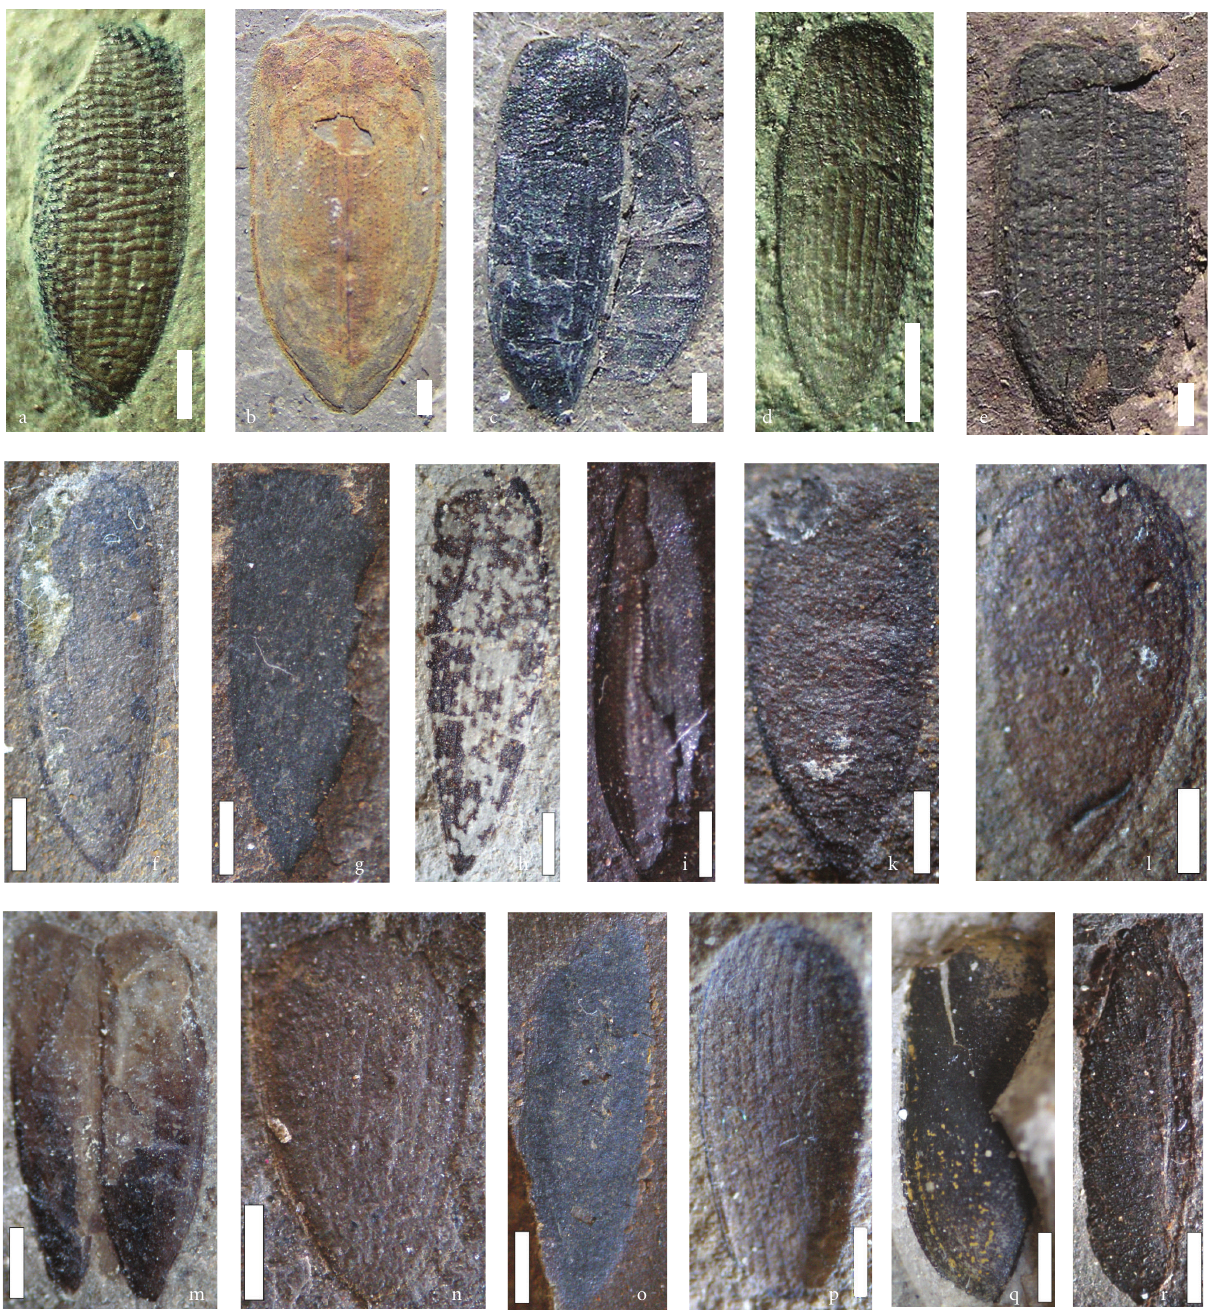
Figure 4: Examples of fossil insects collected from Triassic insects localities, Western Argentina, illustrating the stage of preservation seen in the localities. (a) Argentinocupes pulcher , complete desarticulated elytron. (b) Argentinosyne freng¨uelli , complete articulated elytron. (c) Ademosyne arcucciae , complete articulated elytron and thoracic and abdominal elements. (d) Ademosyne punctuada , complete desarticulated elytron. (e) Argentinocupes abdalai , complete articulated elytron (Martins-Neto et al., [27]); (f)–(r) Indet. material: complete articulated elytron (m) and complete desarticulated elytron ((f)–(l), (n)–(r)). Ornamentation of elytra: smooth ((b), (f), (g), (k), (l), (m), (o), (q), (r)) and striate ((a), (c)–(e), (h), (i), (n), (p)). Scale bar: